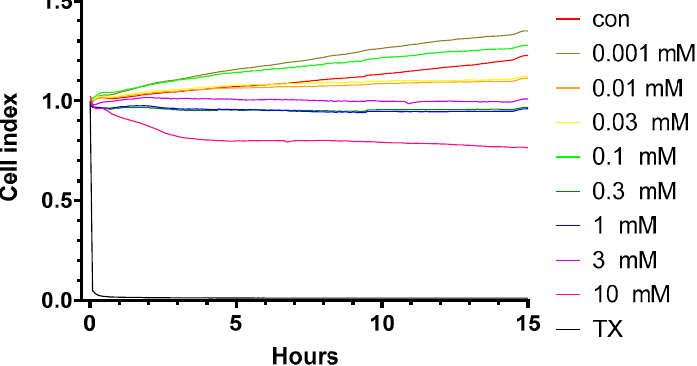
Figure 1. Kinetics of the effect of HPBCD on the viability of primary rat brain endothelial cells monitored by impedance measurement.